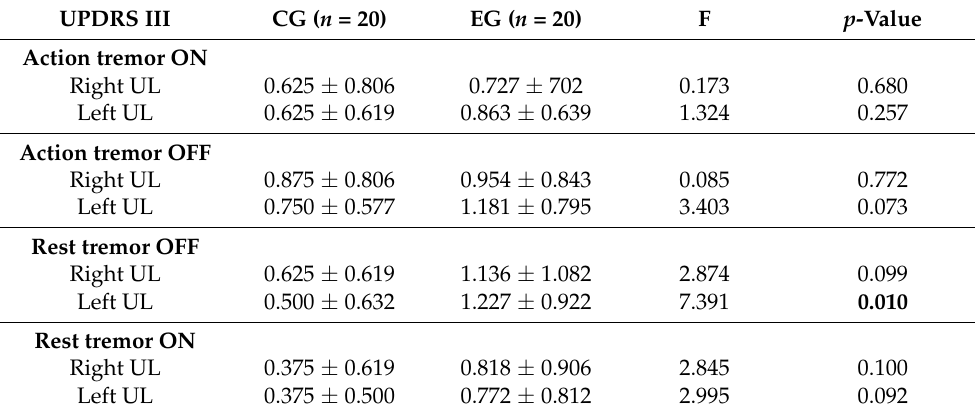
Table 2. Baseline UPDRS scores—resting and action tremor